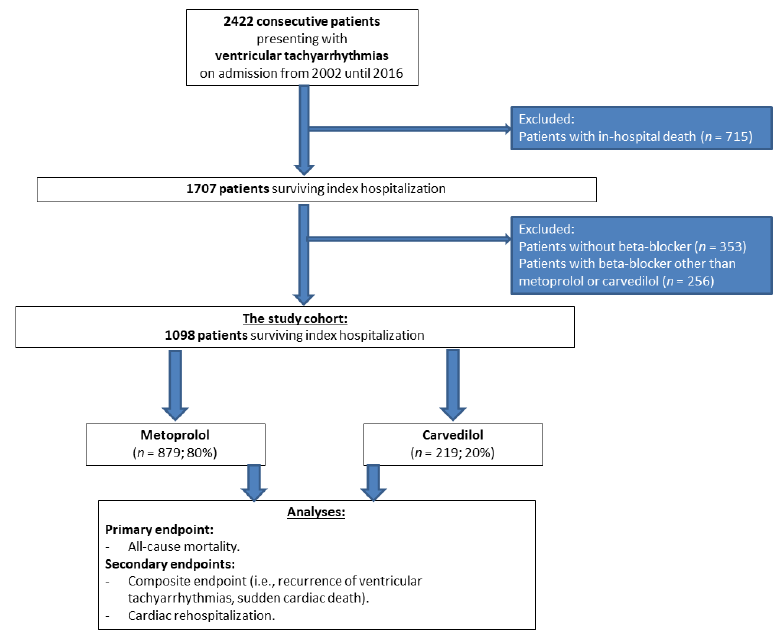
Figure 1. Flow chart of the study population. As seen in Table 1 (left panel), patients had a median age of 67 years, and most pa- tients were males (73–80%). An index episode of VT vs. VF was more common in patients treated with carvedilol (78% vs. 62%; p = 0.001). Cardiovascular risk factors, especially diabetes mellitus (37% vs. 25%; p = 0.001) and hyperlipidemia (39% vs. 31%; p = 0.020), were more common in the carvedilol group. Especially the rates of prior myocardial in- farction, coronary artery disease, and chronic heart failure were higher in patients with carvedilol ( p ≤ 0.02). In line with this, more patients with carvedilol had an LVEF < 35% (63% vs. 29%; p = 0.001). Finally, treatment rates with angiotensin receptor blockers, amio- darone, digitalis, and aldosterone antagonists were more frequently observed in the car- vedilol group ( p ≤ 0.019) (Table 1). Table 1. Baseline characteristics. Without Propensity Score Matching